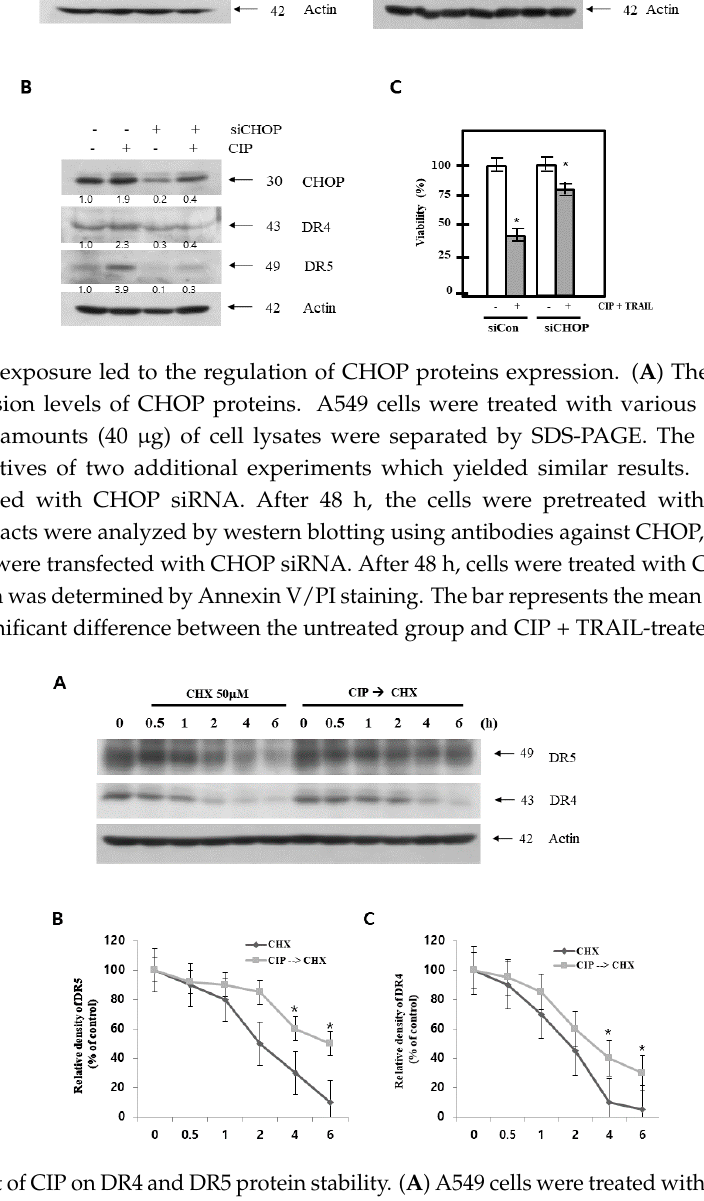
Figure 5. CIP exposure led to the regulation of CHOP proteins expression. ( A ) The effects of CIP on the expression levels of CHOP proteins. A549 cells were treated with various concentrations of CIP. Equal amounts (40 µ g) of cell lysates were separated by SDS-PAGE. The images shown are representatives of two additional experiments which yielded similar results. ( B ) A549 cells were transfected with CHOP siRNA. After 48 h, the cells were pretreated with CIP for 24 h. Whole cell extracts were analyzed by western blotting using antibodies against CHOP, DR4, and DR5. ( C ) A549 cells were transfected with CHOP siRNA. After 48 h, cells were treated with CIP + TRAIL for 24 h. Cell death was determined by Annexin V/PI staining. The bar represents the mean ± SD. * p < 0.01 indicates a significant difference between the untreated group and CIP + TRAIL-treated samples.